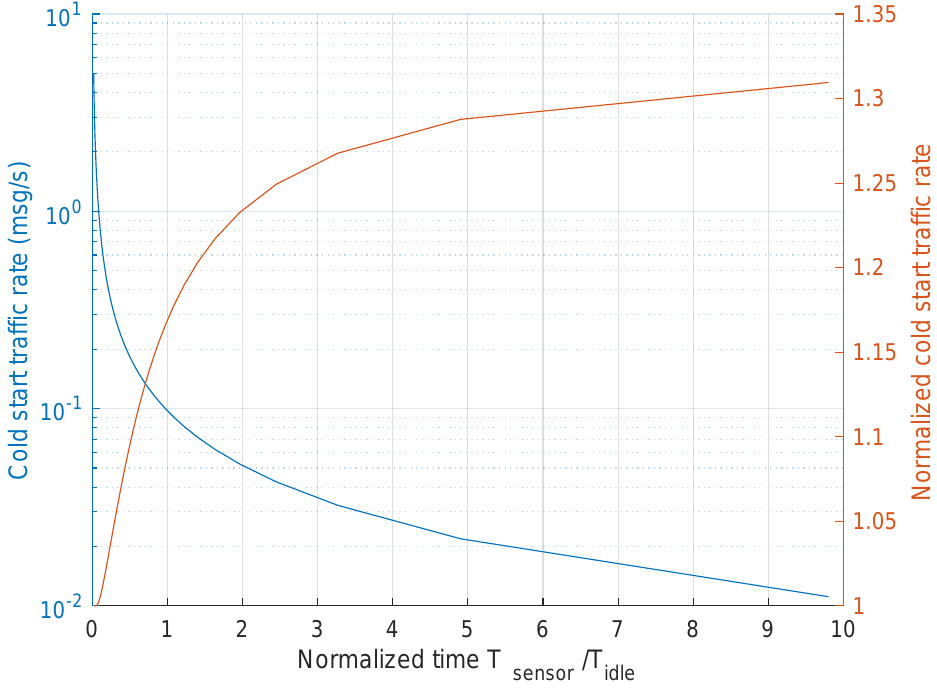
Figure 15. Traffic rate of the cold start mode as a function of the normalized time T sensor / T idle